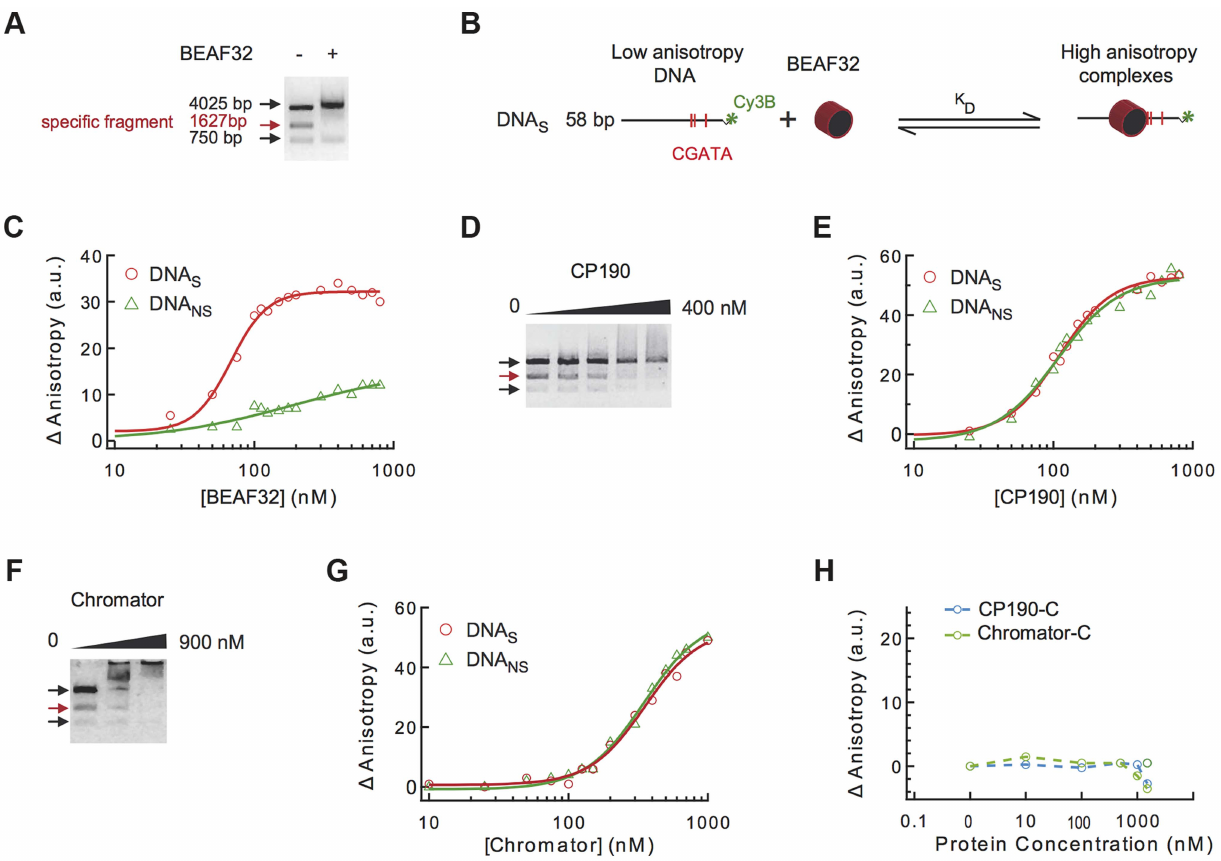
Figure 2. Binding of insulator factors to DNA. (A) Electric mobility shift assay (EMSA) of BEAF32-DNA tudor complexes. A plasmid containing DNA tudor was digested resulting in three linear fragments of size 750, 4025 and 1627 bp (the fragment containing DNA tudor , red). Addition of BEAF32 (200 nM) leads to the preferential disappearance of the band containing CGATA motifs. (B) Scheme representing the experimental setup for fluorescence anisotropy measurements of BEAF32-DNA binding equilibrium. Binding of BEAF32 to DNA S (short DNA fragment containing three CGATA motifs) leads to an increase in the size of the complex that can be detected by an increase in the fluorescence anisotropy signal. K D represents the apparent equilibrium dissociation constant of the complex. (C) BEAF32 binding isotherms for DNA S (red circles) and DNA NS (DNA fragment of the same size as DNA S but with no CGATA motif, green triangles). Solid lines represent fits to a single-site binding (green) or a Hill model (red). (D) EMSA of CP190-DNA tudor complexes show no specificity of DNA binding for CP190 at this genomic locus. In contrast to BEAF32, CP190 shifted the three DNA fragments with similar efficiency even at high protein concentrations (400 nM). Concentrations used were: 0, 100, 200, 300 and 400 nM, respectively. The decrease in the intensity of the top band is less pronounced due to intensity saturation. (E) CP190 binding isotherms for DNA S (red circles) and DNA NS (green triangles). Solid lines represent fits to a Hill model. CP190 binds both fragments with no specificity and equal affinity. (F) EMSA of Chromator-DNA tudor complexes show no specific binding for Chromator at this genomic locus. Concentrations used were: 0, 450, and 900 nM, respectively. The intensity of all bands is decreased to the same extent by the binding of Chromator, reflecting non-specific binding to these DNA fragments. (G) Chromator binding isotherms for DNA S (red circles) and DNA NS (green triangles). Solid lines represent fits to a Hill model. Consistent with (F), Chromator binds both fragments with no specificity. (H) CP190-C (light blue) and Chromator-C (green) binding isotherms for DNA S . Addition of large protein concentration does not lead to detectable changes in fluorescence anisotropy. assay that directly measures the binding of proteins to DNA. The binding of proteins, such as BEAF32, to short fluorescently-labeled DNA fragments decreases the rotational diffusion of the DNA